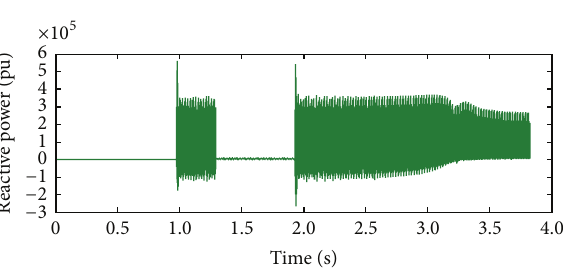
Figure 19: Reactive power during LLLG fault.